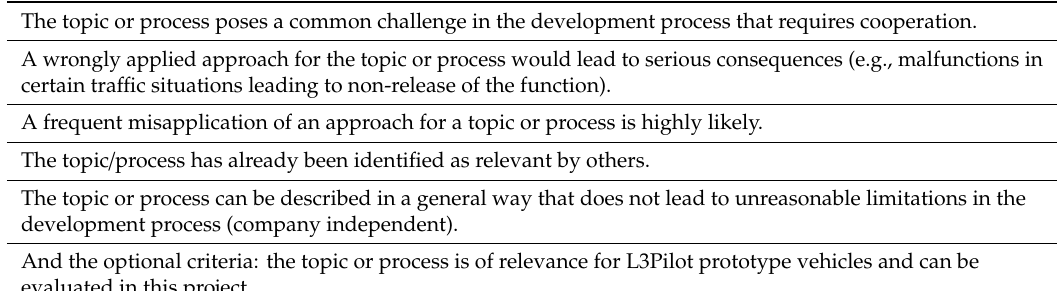
Table 1. Criteria for inclusion of topics into the Code of Practice for automated driving